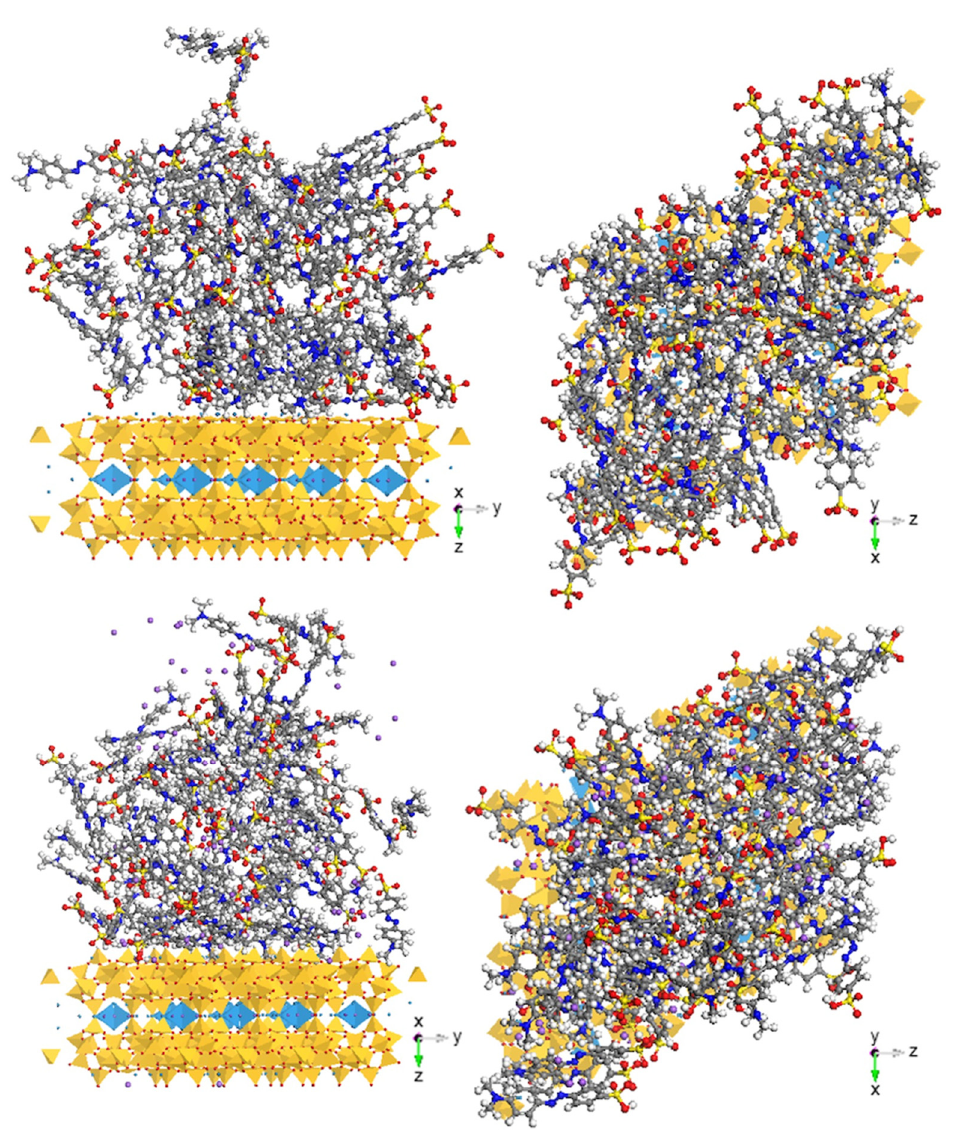
Figure 6. Molecular dynamic simulation showing MO uptake in the absence ( top ) and presence ( bottom ) of counterion Na + on the ac plane of clinoptilolite projected along a ( left ) and b ( right ) directions. For MO: red: O; blue: N; grey: C; white: H; purple: Na + . For clinoptilolite: the blue diamonds in the channels are hydrated exchangeable cations with octahedral coordination.